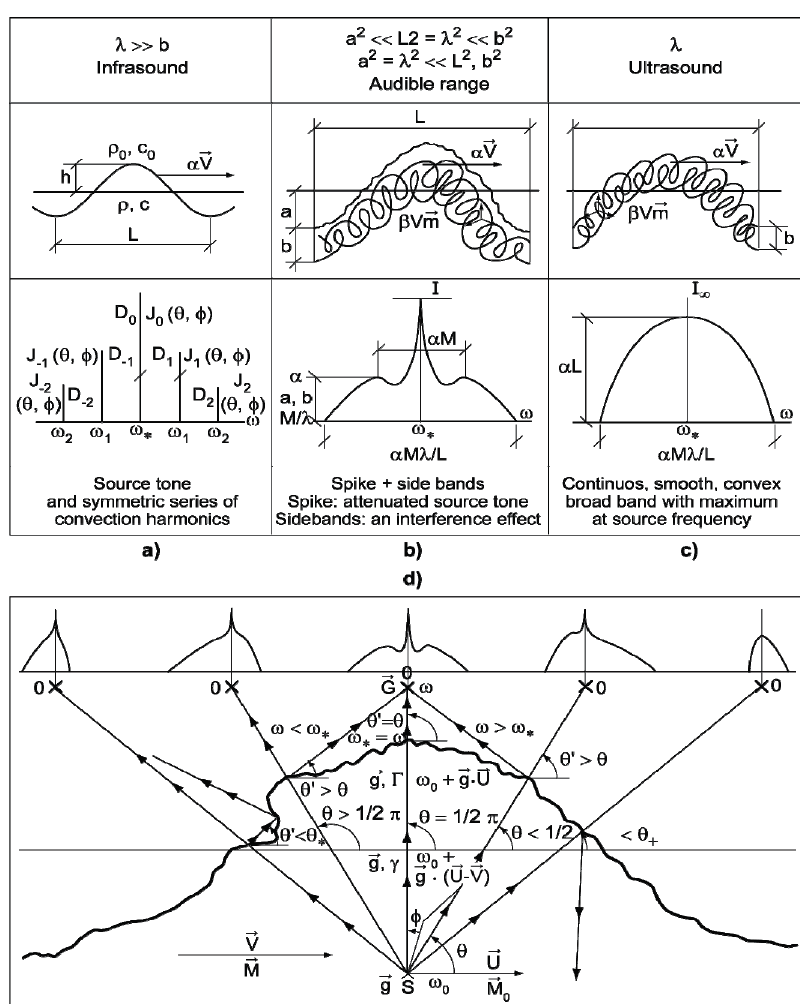
Figure 5. Sound transmission across a turbulent and irregular shear layer. Noise shielding in jet shear layers [258,259] involves: (i) the noise sources in the jet (Figure 1) that may be vorticity and inhomogeneities associated respectively with “vortex” and “entropy” noise; (ii) the noise is received by an observer outside after transmission across the shear layer; (iii) the shear layer is a randomly irregular interface across which change the flow quantities like velocity, sound speed and mass density; (iv) the shear layer entrains a region of turbulence that also refracts sound. A moving interface with fixed shape would transmit ( a ) tones with a Doppler shift for low-frequency waves. High frequency waves ( b ) would lead to a broadband due to random Doppler shifts (Figure 8). At intermediate frequencies ( c ) there are both source tones and spectral broadening (Figure 8) due to turbulence (Figure 7) and the irregularity of the shear layer. Even for a monochromatic monopole, that is a source with a single frequency and uniform radiation pattern (Figure 5), the observer outside the jet ( d ) receives: (i) an attenuated tone with some of the acoustic energy going to broadband; (ii) the rescattering of sound from the source by all shear layer elements leads to a different spectrum for each direction; (iii) the total energy in each spectrum for each direction leads to the directivity. Thus the spectra and directivity of sound received outside the jet, after transmission across the turbulent and irregular shear layer, may be